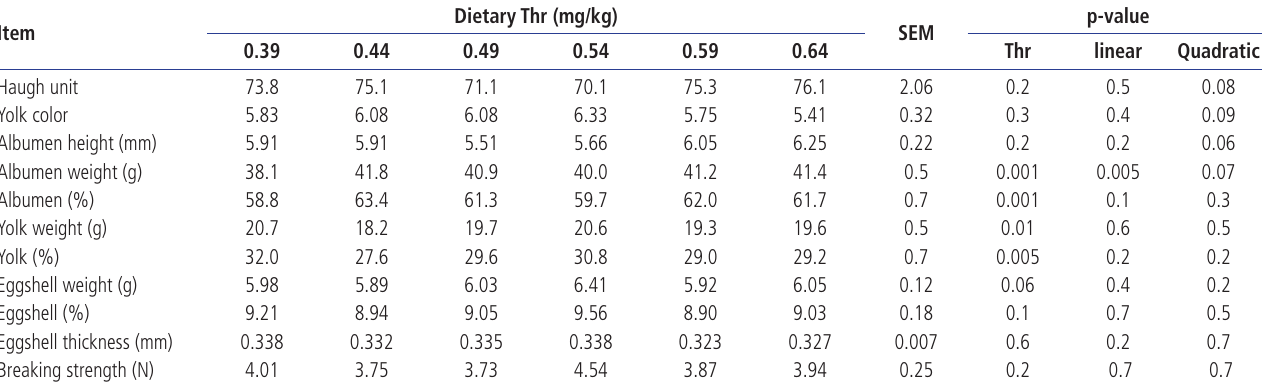
Dietary Thr (mg/kg)